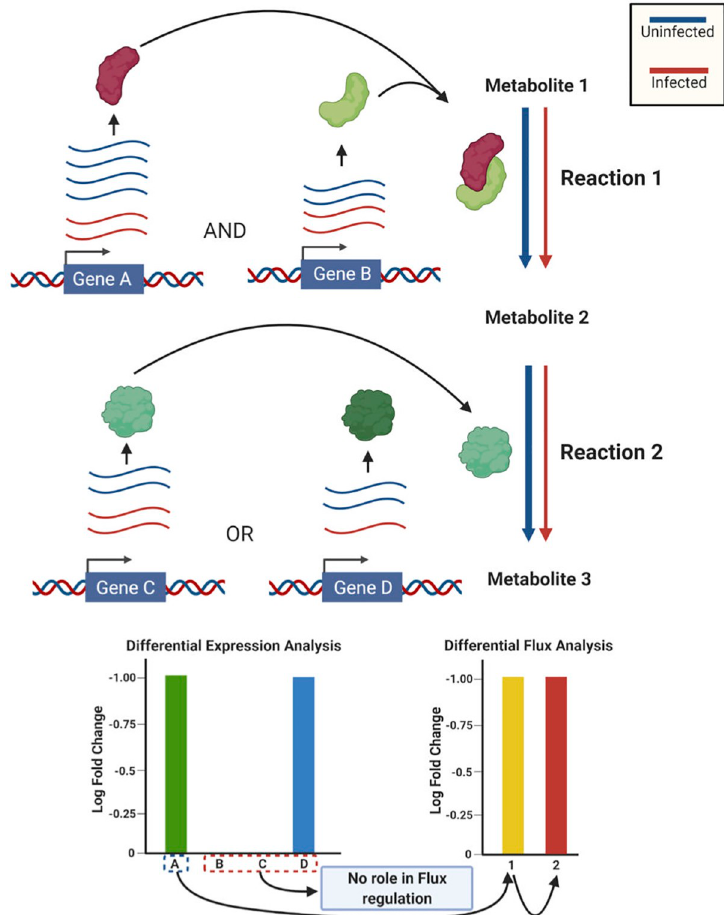
Fig 4. Boolean relation between activity of enzymes and the gene encoding the proteins in the complex makes the prediction of flux from expression difficult. Gene A and Gene B encodes subunits of the enzyme which catalyzes ‘Reaction 1’. Gene C and Gene D encode two alternative isozymes which catalyzes ‘Reaction 2’. The width of the arrow for ‘Reaction 1’ and ‘Reactions 2’ represents the level of flux. The black arrow is in the direction of cause to effect. A fold change in the expression of A is sufficient to change the flux through reaction 1 which further changes through reaction 2. All the enzymes are assumed to have their concentration above the threshold. (Created with BioRender.